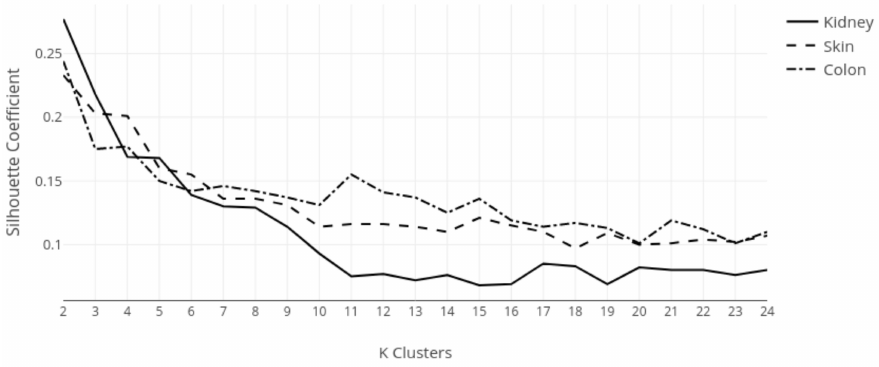
Figure 10. Silhouette scores for tissue types across searched K